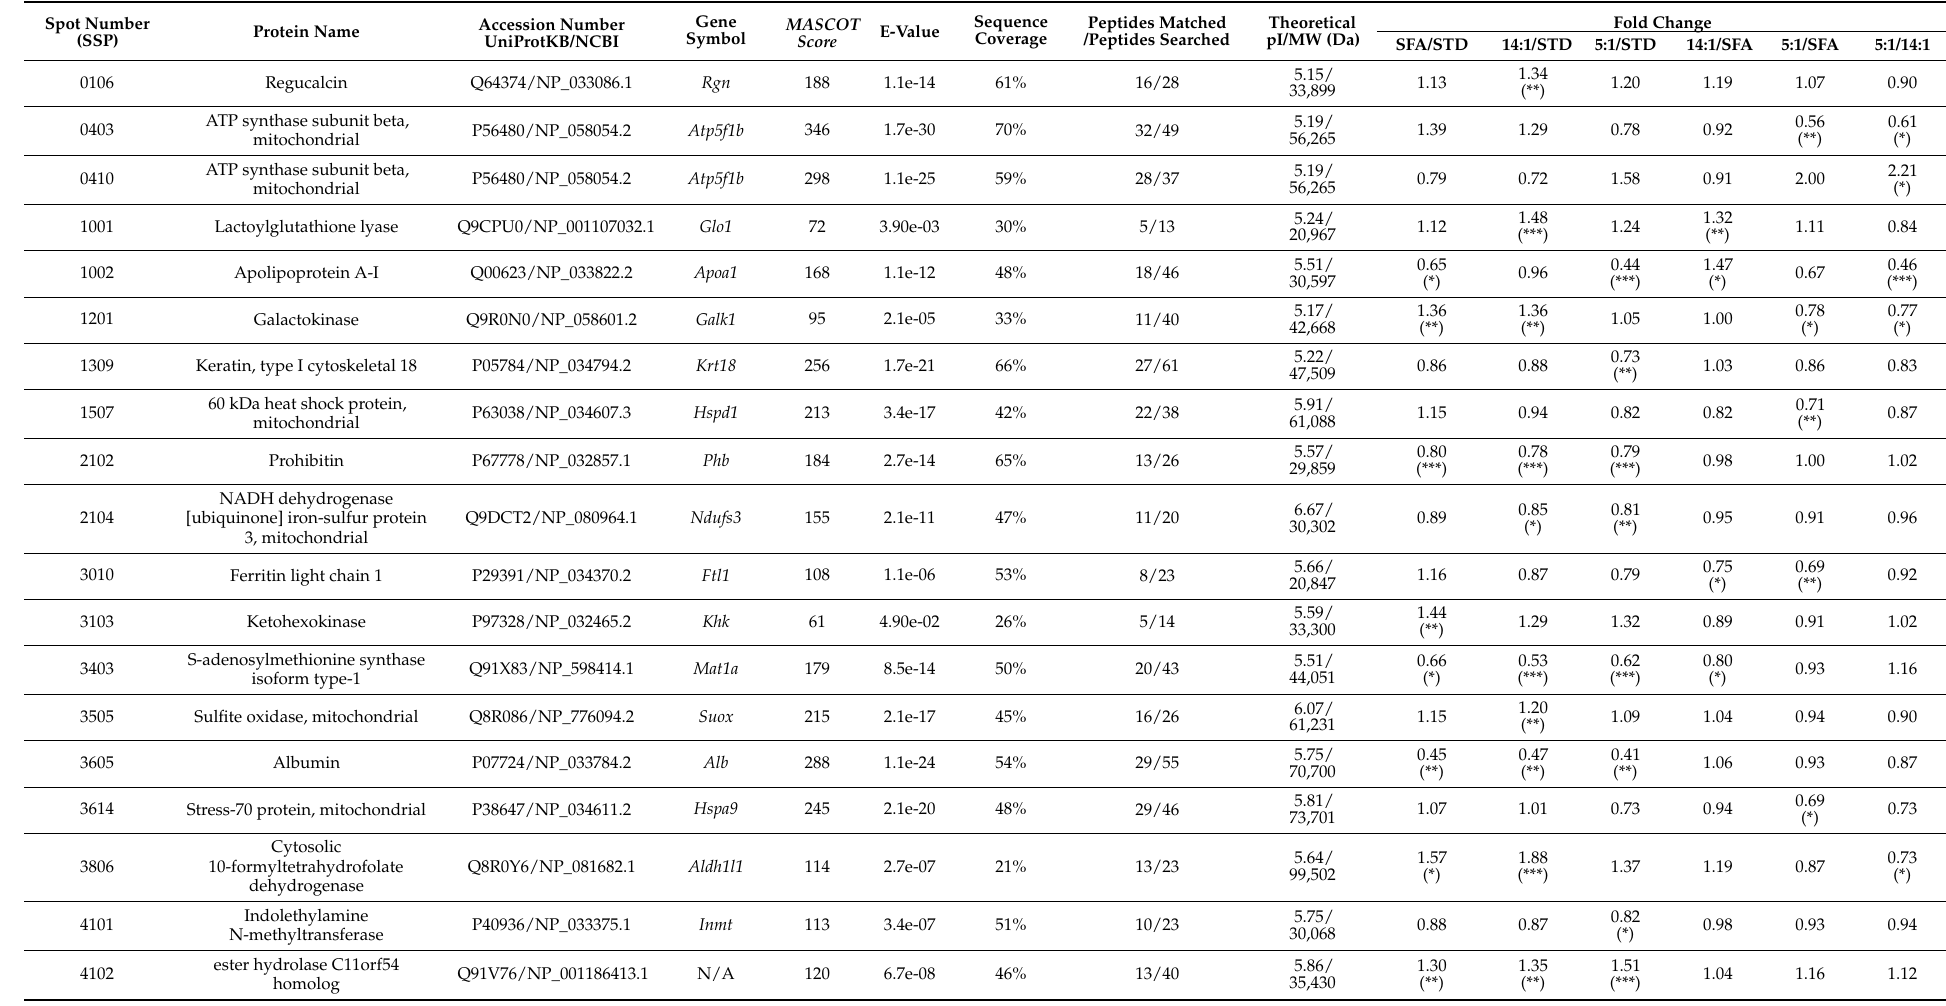
Table 3. Differentially expressed protein spots between the standard (STD) and the high-fat diet groups (SFA, 14:1, 5:1) in mouse